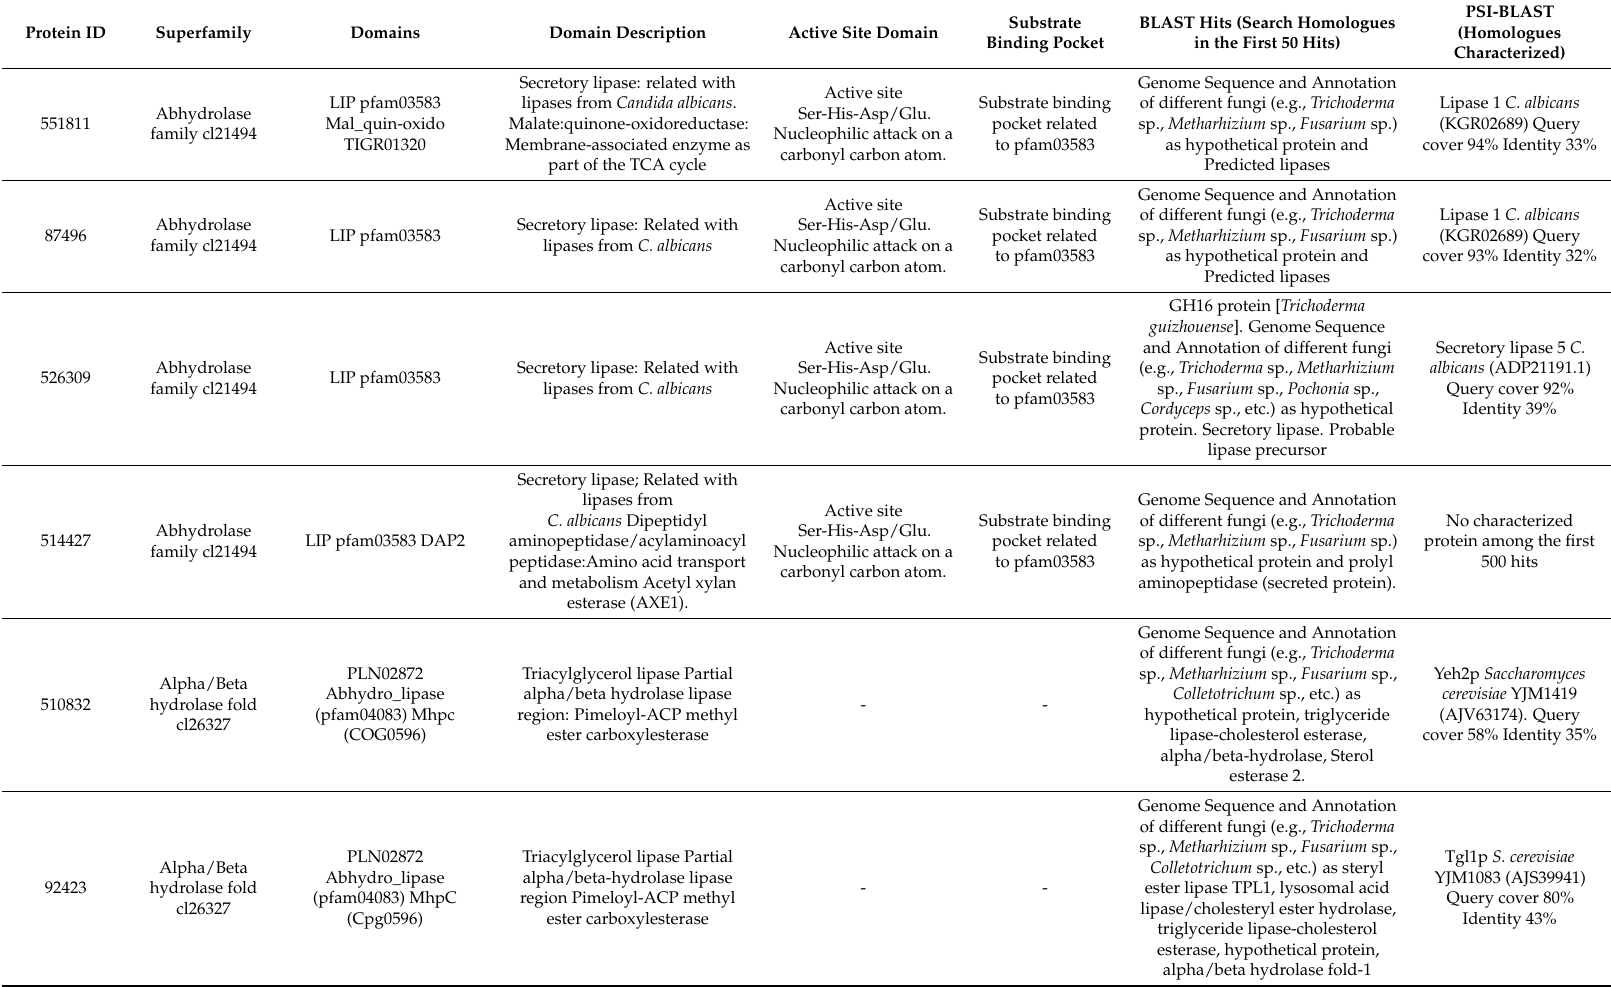
Table 2. List of domains and family description of putative true lipases of Trichoderma harzianum